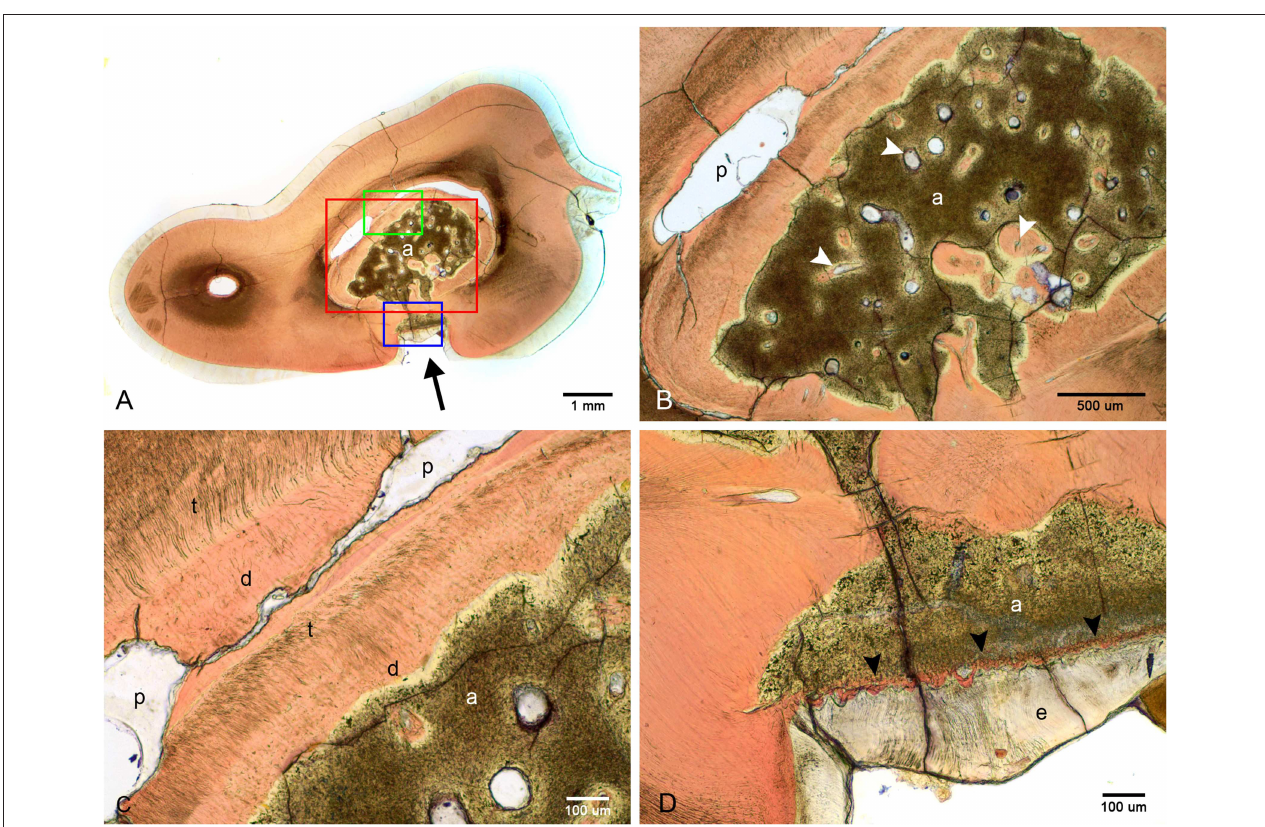
FIGURE 5 | Ground sections of the left mandibular first molar tooth from dog 6. (A) Low magnification of a mid-coronal dorsal section through the abnormal tissue and enamel fissure (black arrow). (B) Medium magnification of the area marked by the red rectangle in (A) . Several channels traversing the abnormal tissues (white arrowheads), some surrounded by dentin-like material. (C) High magnification of the area marked by the green rectangle in (A) . Disorganized dentin is visible lining the abnormal tissue and the pulp. (D) High magnification of the area marked by the blue rectangle in (A) , demonstrating a thin band of dentin-like tissue separating the abnormal tissue and enamel (black arrowheads). a, abnormal tissue; d, disorganized dentin; t, tubular dentin; e, enamel; p,